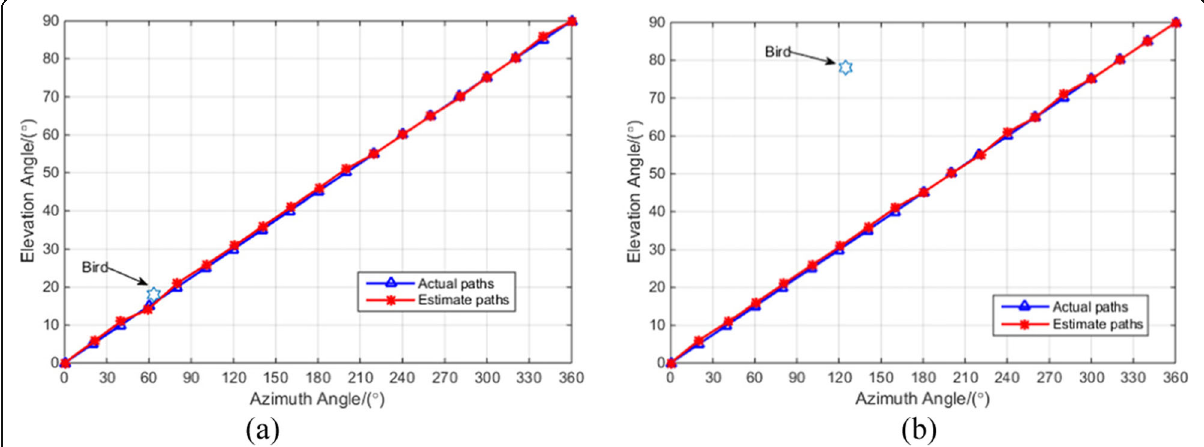
Fig. 21 Tracking accuracy with interfering sound signals. a Direction of interfering sound signal (18°, 63°). b Direction of interfering sound signal (78°,